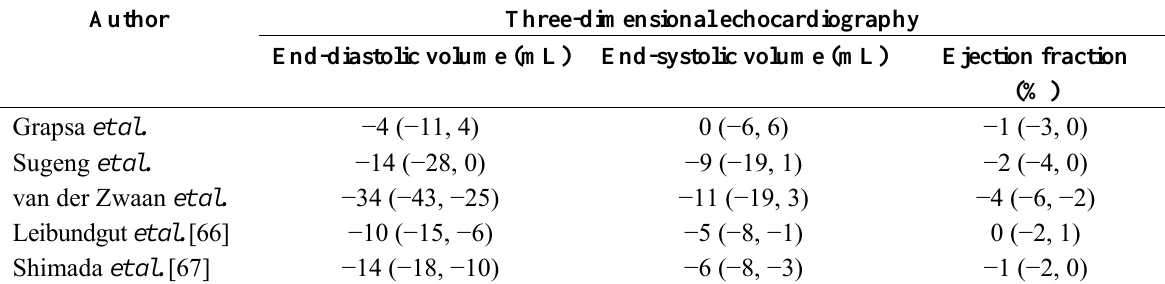
Table 1. Differences between right ventricular volumes assessed by three-dimensional echocardiography and cardiac magnetic resonance (Modified from: Badano et al. [61]).